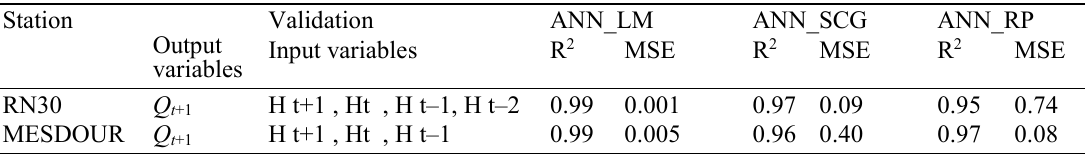
Table 1 Performance of ANN model with different